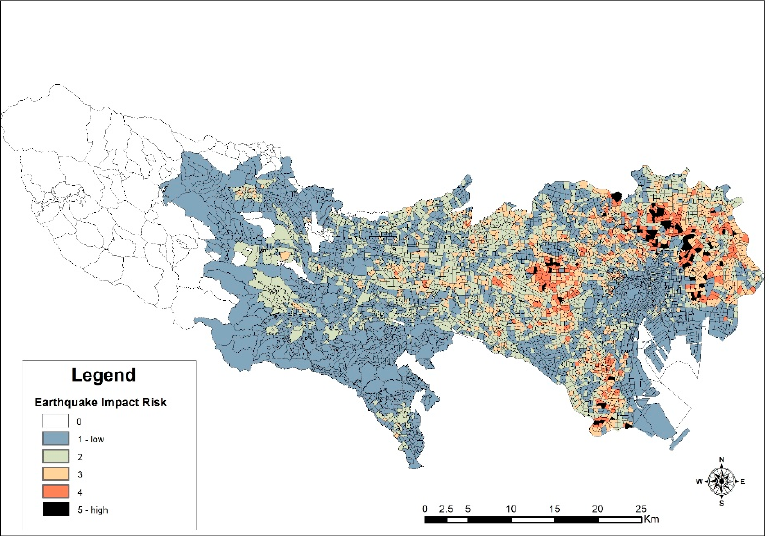
Figure 5. Diversity within cities in the Tokyo metropolitan area.